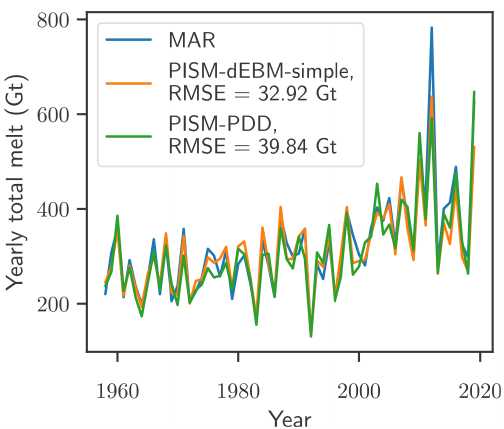
Figure D1. Comparison of annual total melt of the Greenland Ice Sheet as calculated with MAR v3.11 and PISM-PDD. The diag- nostic simulation with PISM-PDD (green line) is performed using monthly MAR 2D temperature fields as forcing. The root-mean- square difference between the PISM-PDD simulation and total melt as given by MAR (blue line) is 39.84Gt. Details on the PISM- dEBM-simple simulation are found in Fig. 1 and in Sect.